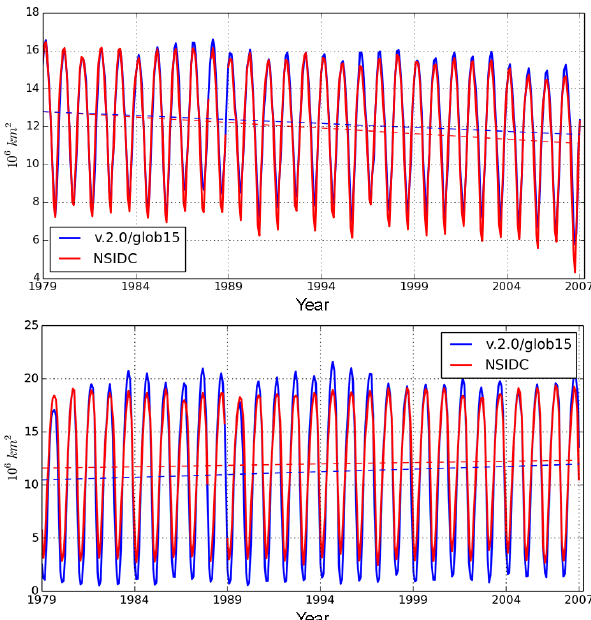
Figure 8. The simulated ice extent in the Northern (top) and South- ern (bottom)